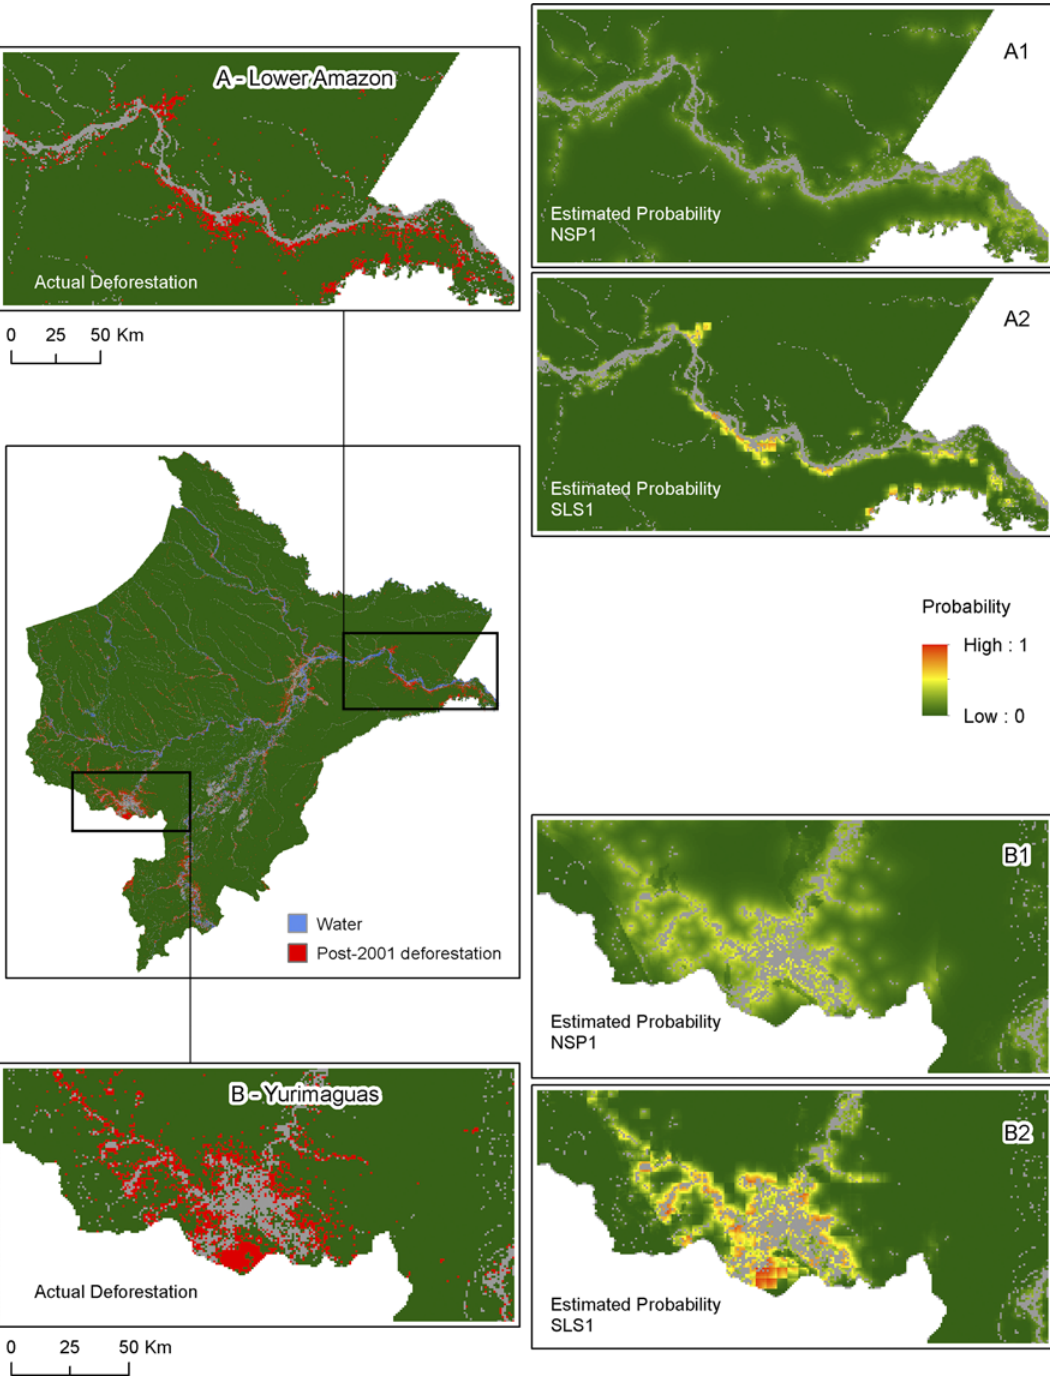
Fig 2. Actual deforestation and estimated probabilities. (A) Actual deforestation along the lower Amazon River from 2001 – 2014. (B) Actual deforestation near Yurimaguas from 2001 – 2014. (A1 & B1) – Estimated probabilities from NSP1 model. (A2 & B2) Estimated probabilities from SLS1 model.